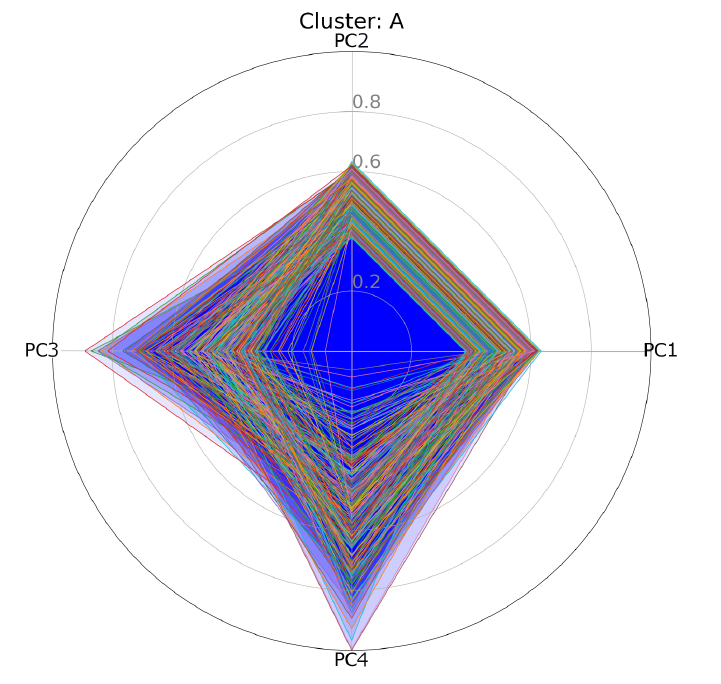
Figure 11. Stacked radar graphics showing cluster A of normalized values for case